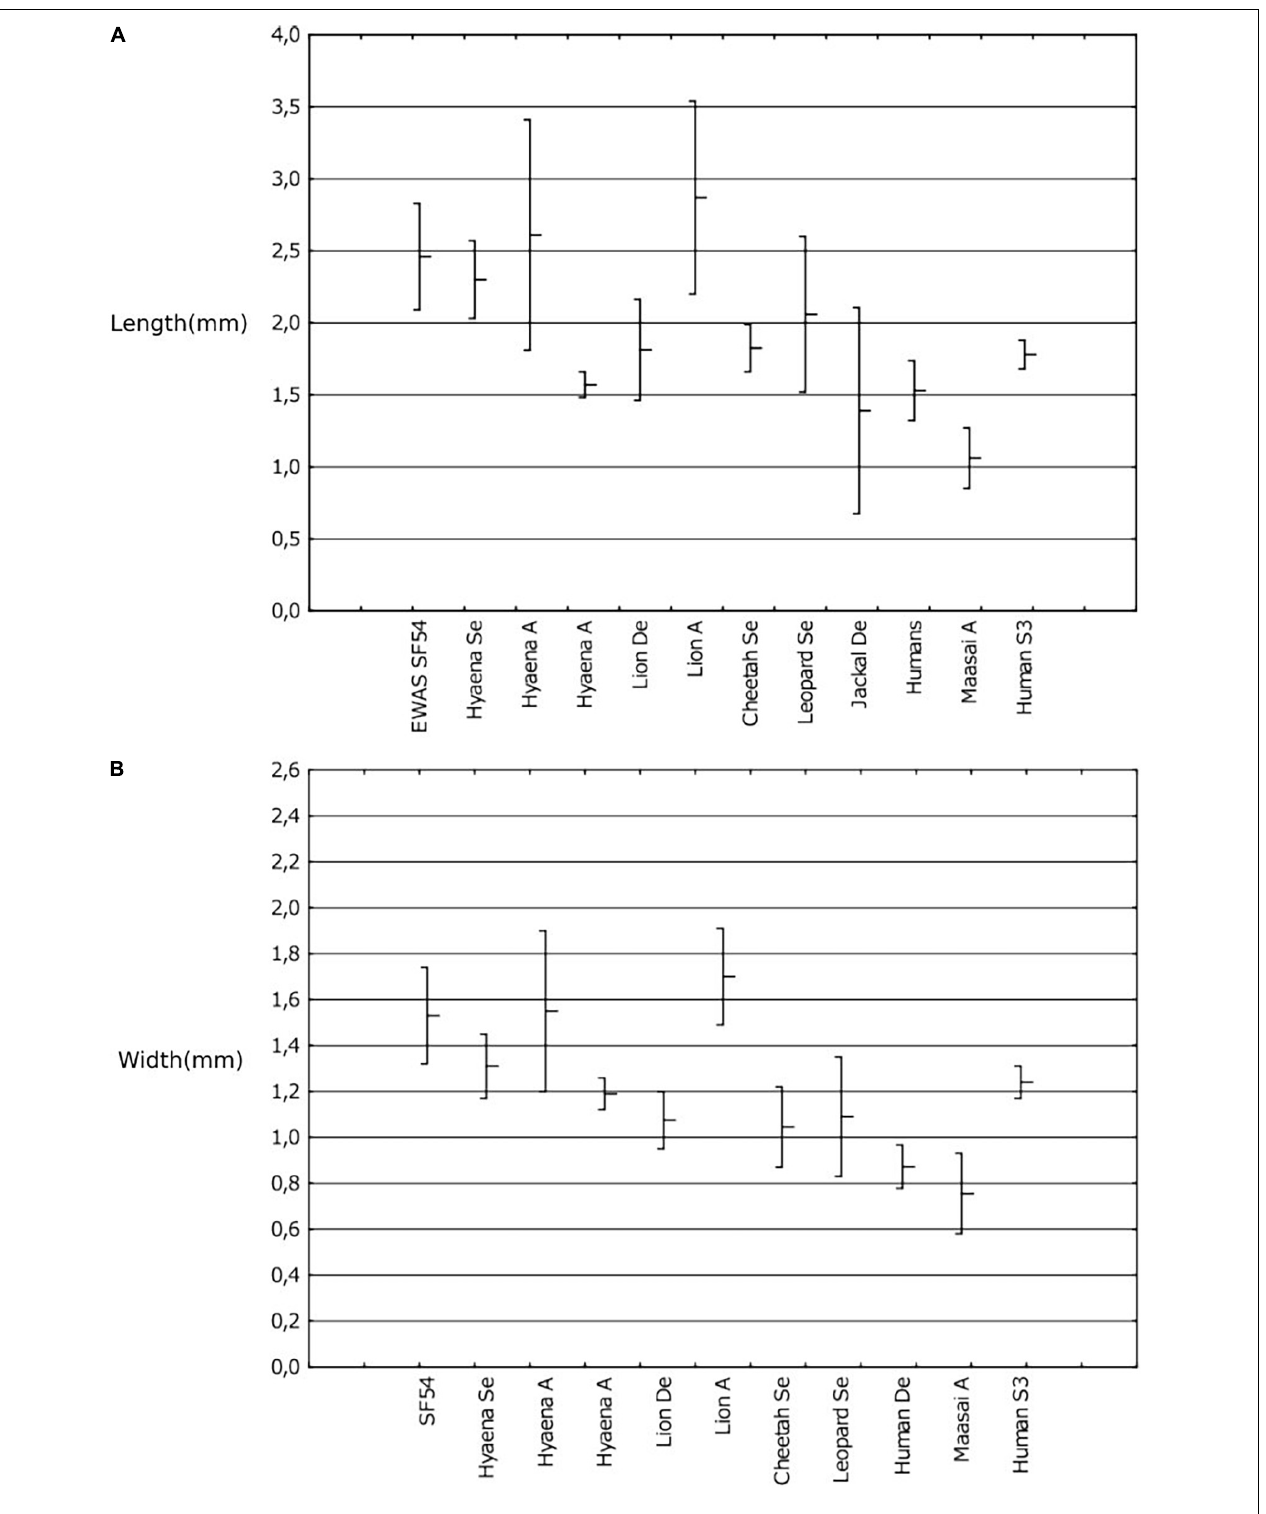
FIGURE 6 | Measurements [mean and 95% confidence intervals in mm; length: (A) ; width: (B) ] compared with known carnivore measurements. Indicates Measurements of specimen SF54 compared with living and known carnivore measurements (length: (A) , width: (B) , mean and 95% confidence intervals in mm) Pit lengths- Selvaggio (1994), Delaney-Rivera et al. (2009), Andrés et al. (2012), Ewass (2019) and Humans S3-Saladié et al. (2013).